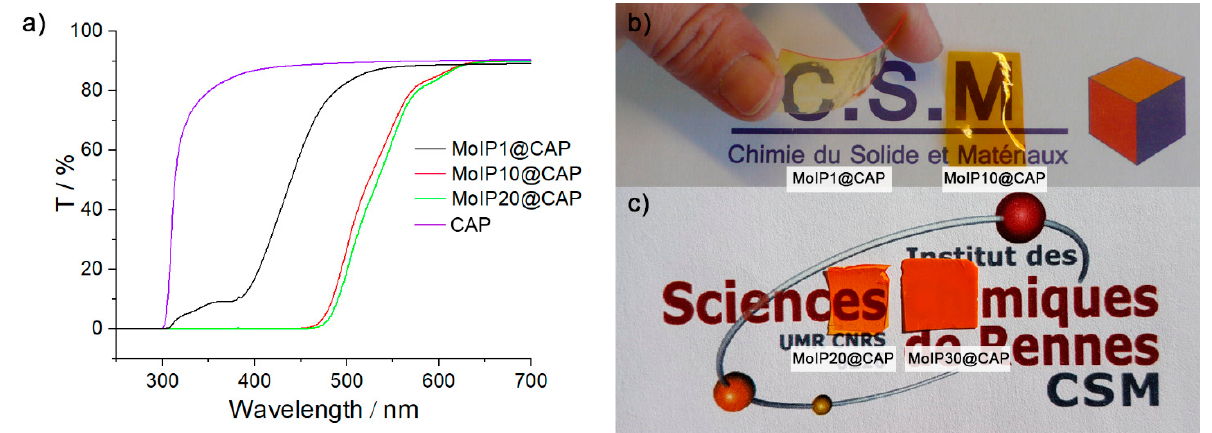
Figure 4. ( a ) Films transmittance of CAP (purple), MoIP1@CAP (black), MoIP10@CAP (red), and MoIP20@CAP (green). Pictures and natural light of ( b ) MoIP1@CAP and MoIP10@CAP , ( c ) MoIP20@CAP and MoIP30@CAP.